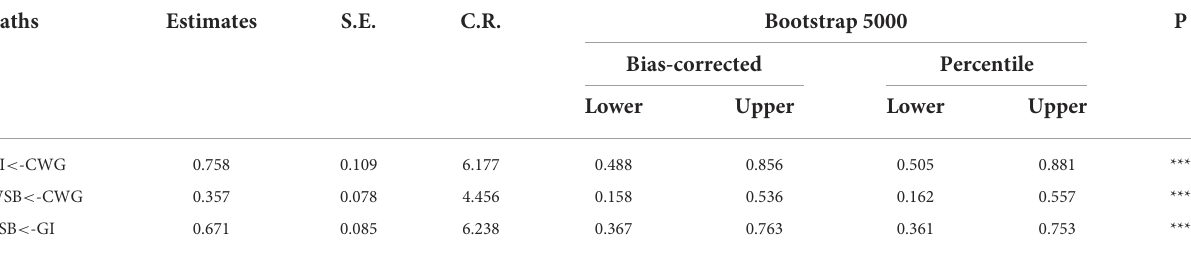
TABLE 5 Significance analysis of regression coefficients. Paths